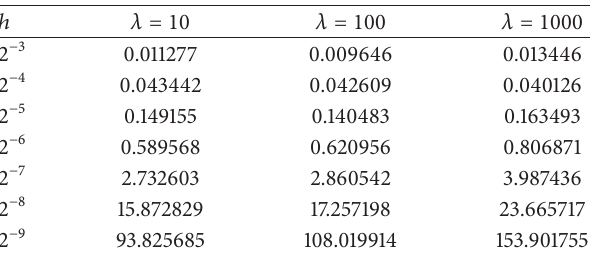
Table 4: The CPU times for nonsmooth multigrid-Newton algo-